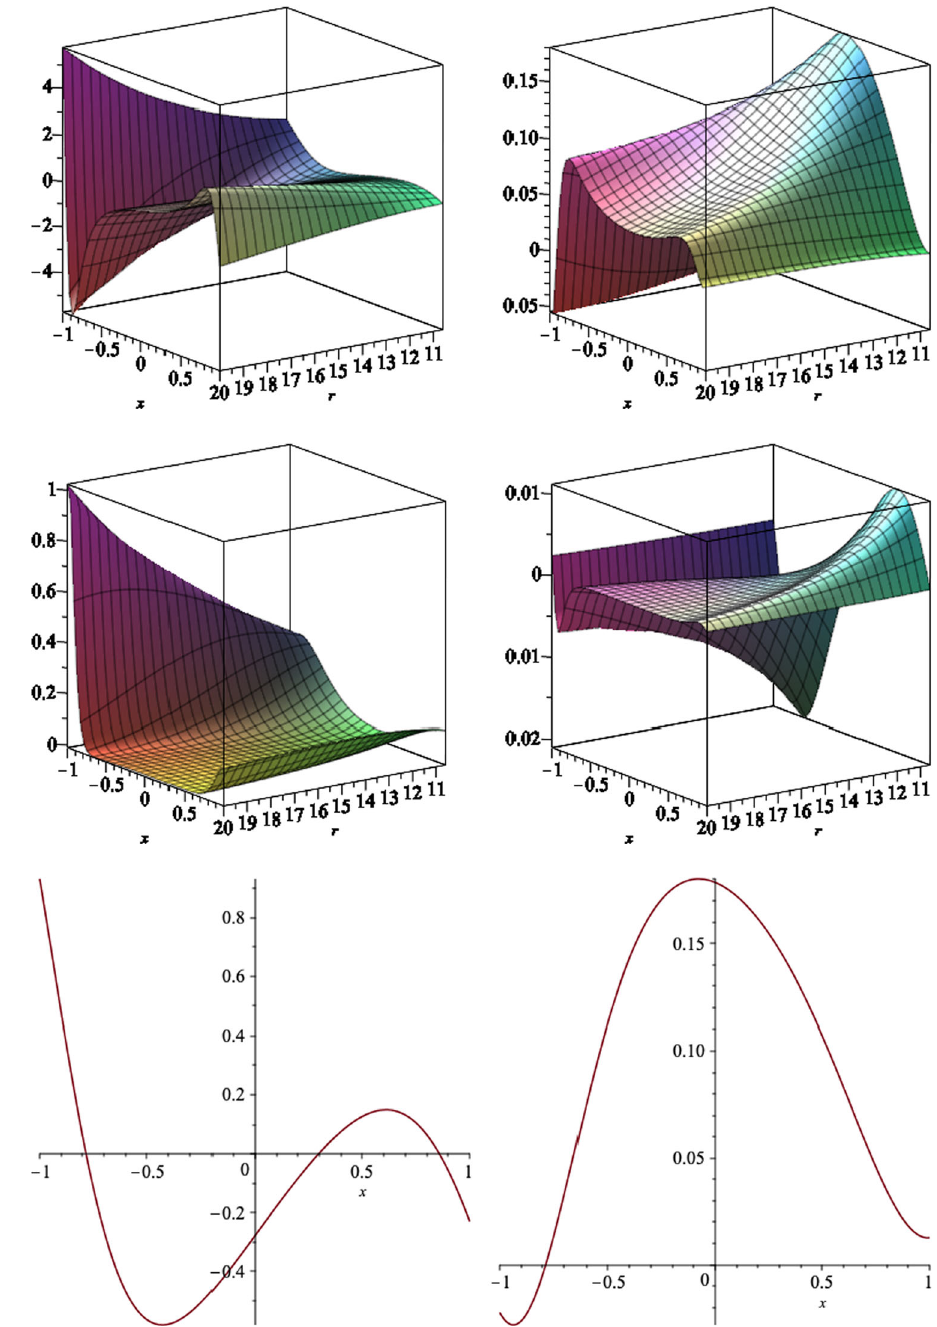
Fig. 6 The r (left) and x (right) components of the magnetic field, versus r and x , for a black hole which the event horizon is located at r + = 10 . 6. We set the black hole parameters as a = 6 , q = 1 , m = 7 , l = 1 and b = 2